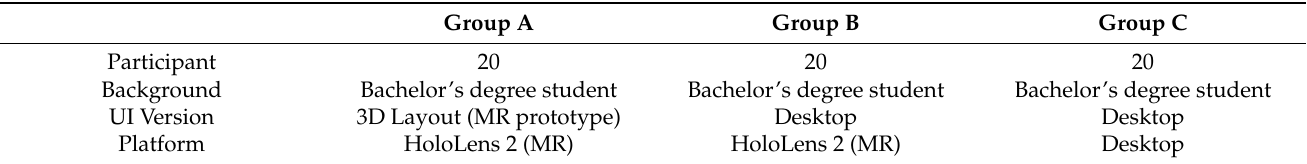
Table 1. Demographics of the